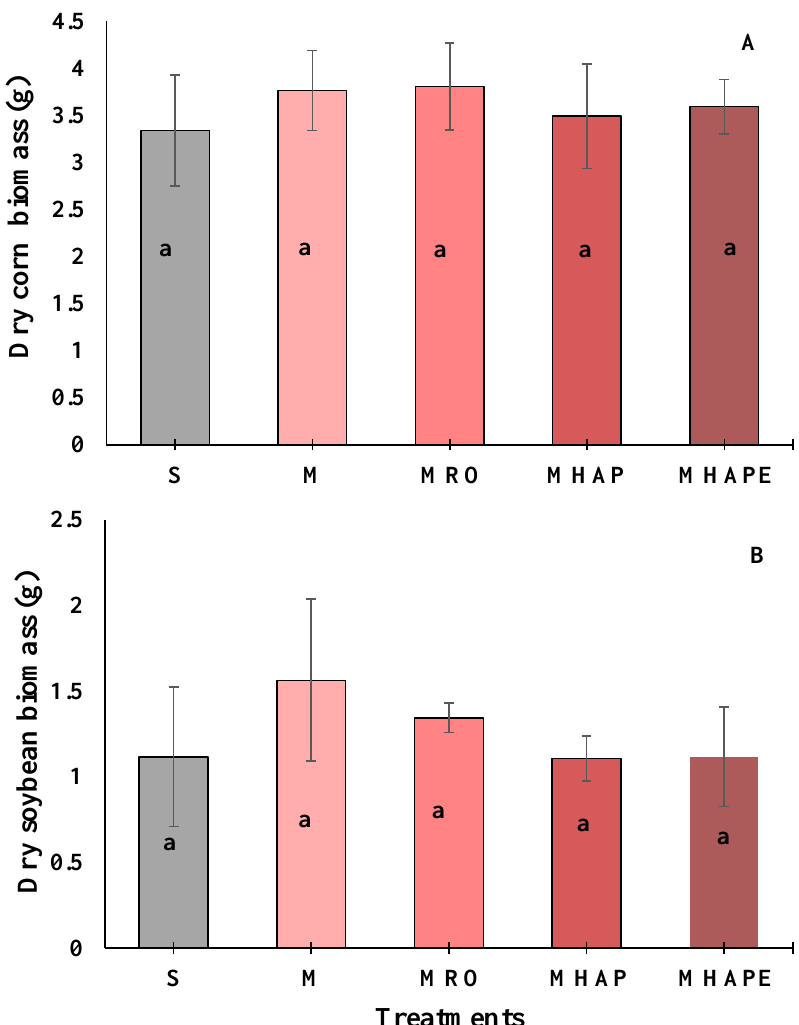
Figure 7. The effect of treatments on the biomass yield for corn ( A ) and soybean ( B ) biomass. Each bar represents an average of 4 replications ± standard deviation. S = soil control; M = manure control; MRO = manure + red oak biochar; MHAP = manure + highly alkaline porous biochar; MHAPE = manure + corn feedstock autothermal porous Fe-engineered biochar. Different letters show the treatments that are statistically different at p < 0.05 level.